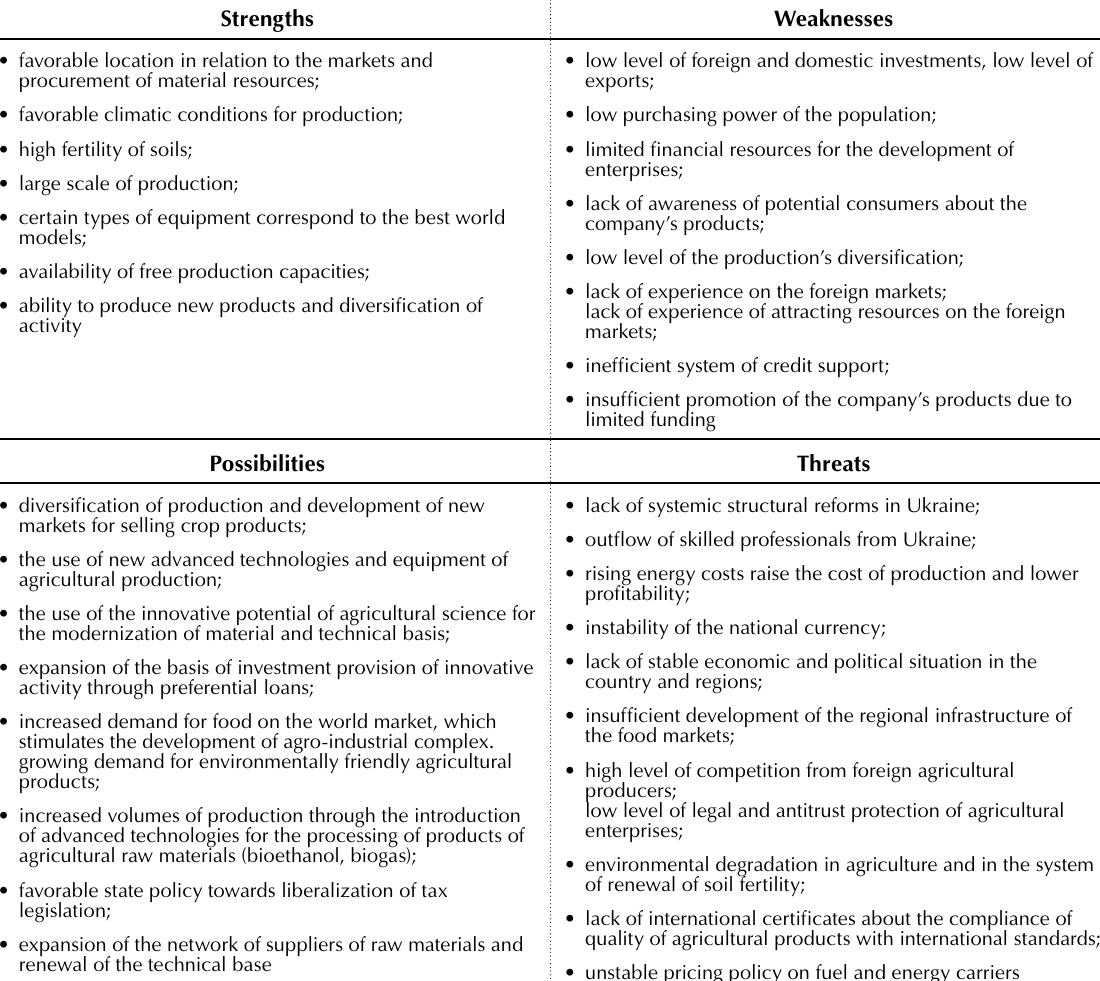
Table 3. SWOT-analysis of innovative and investment activity of agricultural